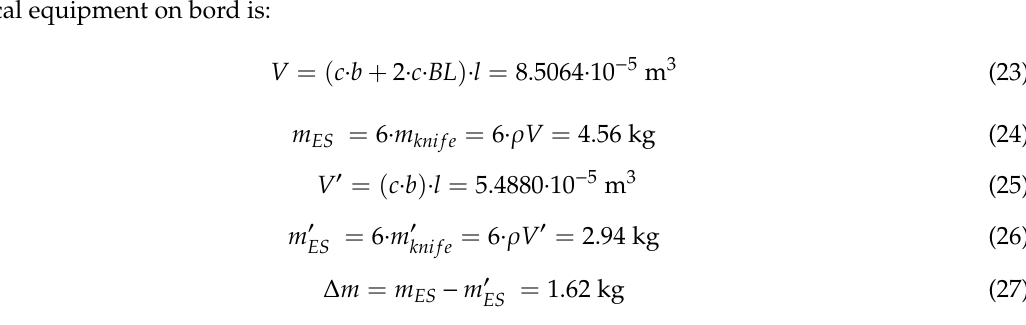
Figure 17. Share of different transportation modes in Greenhouse Gas (GHG) emissions in the European Union (EU), source [24].